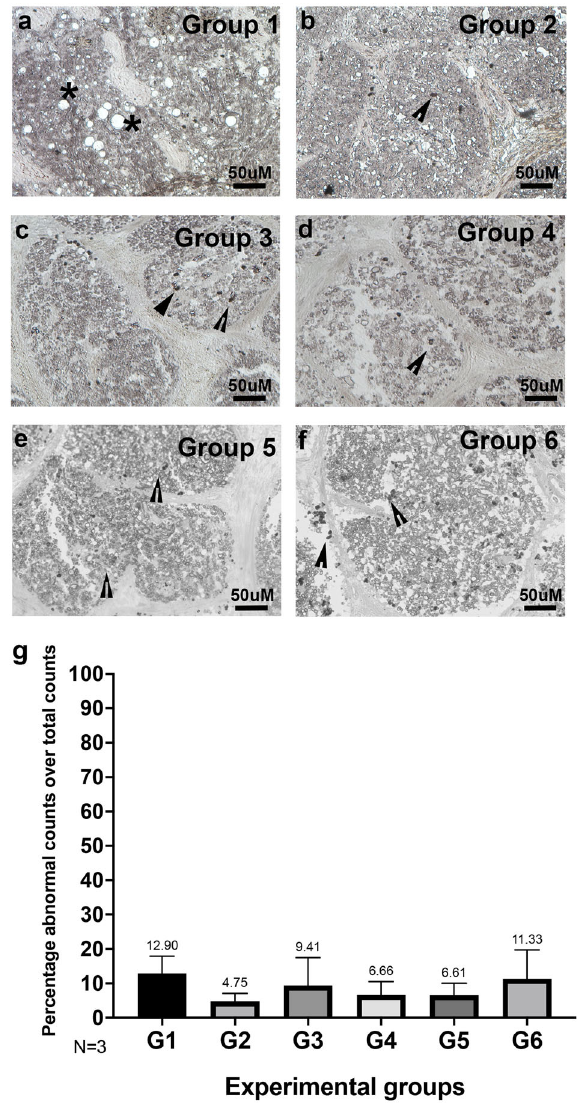
Fig. 5 Degeneration of optic nerve axons observed under experimental conditions. Paraphenylenediamine (PPD) staining of the optic nerve was utilized to assess degeneration of axons within the nerves of ( a ) Group 1, ( b ) Group 2, ( c ) Group 3, ( d ) Group 4, ( e ) Group 5 and ( f ) Group 6 cultured for 14 days within the TAS model. Normal and healthy axons (asterix); damaged or dying axons (arrowhead). a – f 400x magni fi cation. g Ratio of abnormal to total axon counts normalized to control, N = 3. Data are presented as mean ± standard error of the mean and P < 0.05 was considered statistically signi fi